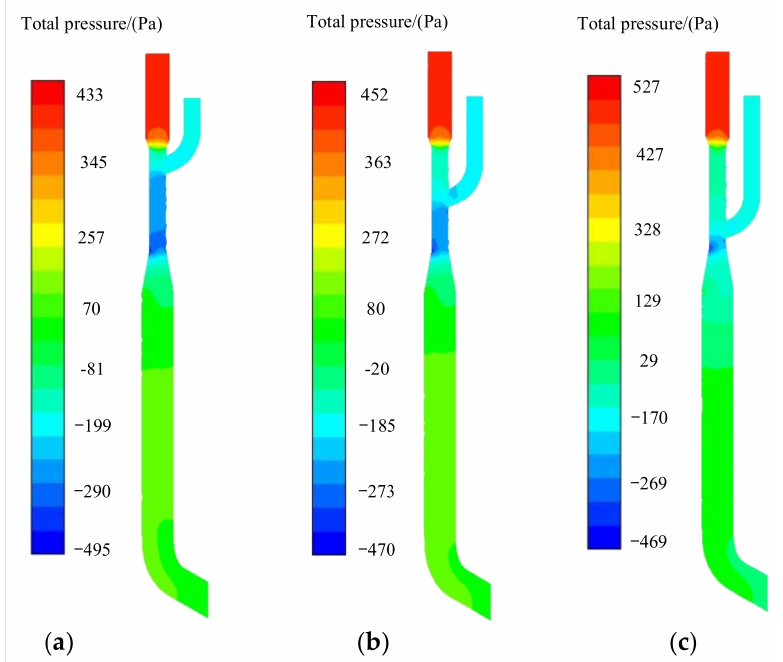
Figure 6. Airflow-pressure contours of different intake seed chamber locations. ( a ) Upper, ( b ) central, ( c )